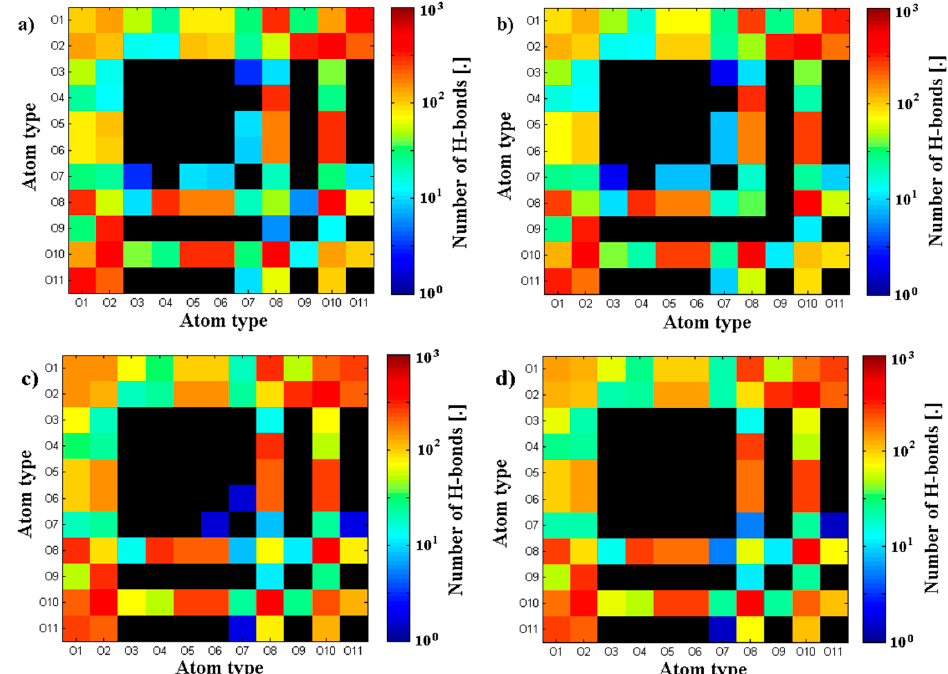
Figure 7. Map of average H-bond length between specific oxygen atoms of (A-) chains. Two cases of short (A-) are presented: ( a ) short (A-) solution; ( b ) short (A-) solution + PL; ( c ) long (A-) solution; ( d ) long (A-) solution + PL. Black color indicates no H-bond found between two atoms.